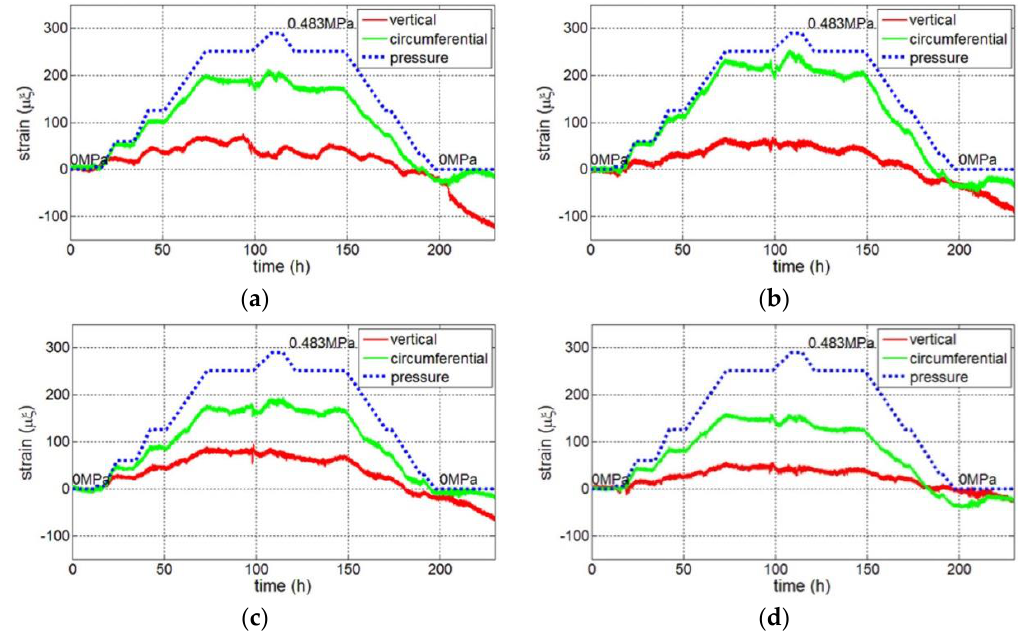
Figure 7. The monitoring results in vertical direction and circumferential direction. ( a ) Measuring point MP 1; ( b ) MP 2; ( c ) MP 3; ( d ) MP 4. point MP 1; ( b ) MP 2; ( c ) MP 3; ( d ) MP